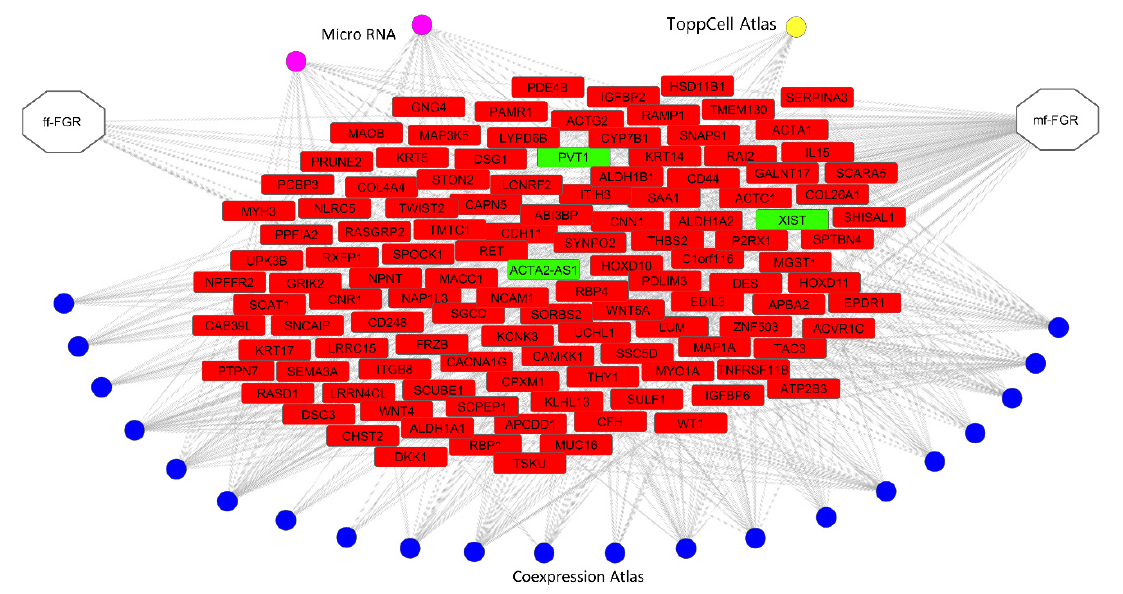
Figure 5. The relationship network enriched with ToppCluster. The presented relations were selected from three categories: miRNA (purple circles), the Coexpression Atlas (blue circles) and the ToppCell Atlas (yellow circles). Relations for genes (red rectangles) and lncRNAs (green rectangles) present a common part of the whole ToppCluster enrichment for both the ff-FGR and mf-FGR sets of genes.